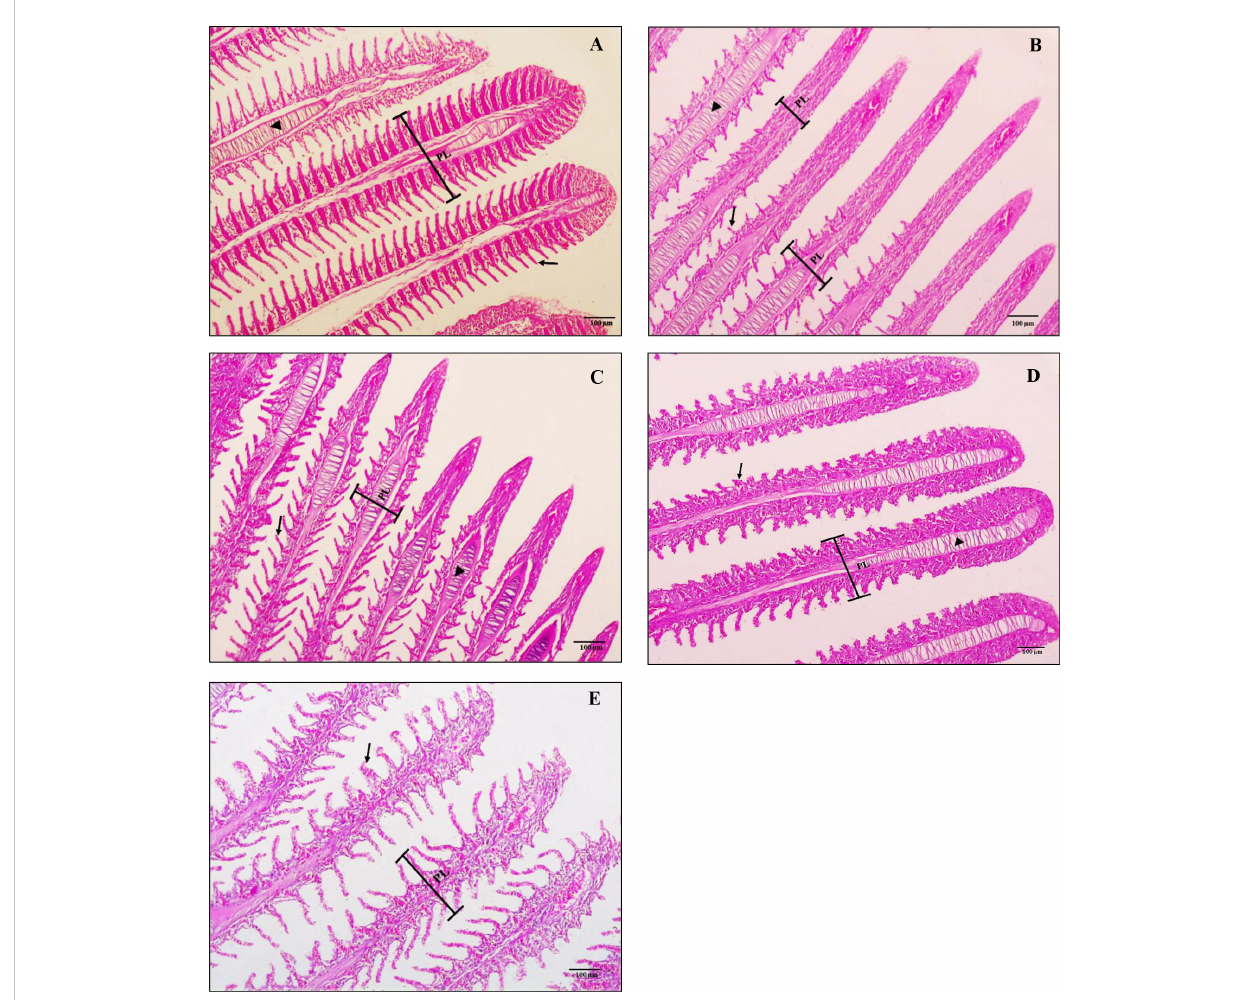
FIGURE 4 Screening cross-section of the gills of hybrid red tilapia fed different ratios of corn oil (CO): Aquafat-O ® (AQ-O) and exposed to cold stress. (A) the negative treatment (T